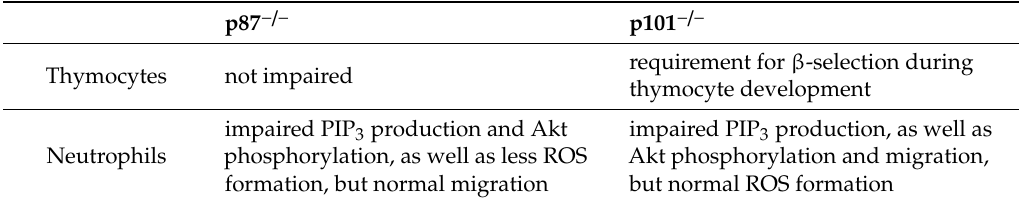
requirement for β -selection during thymocyte development impaired PIP 3 production, as well as Akt phosphorylation and migration, but normal ROS